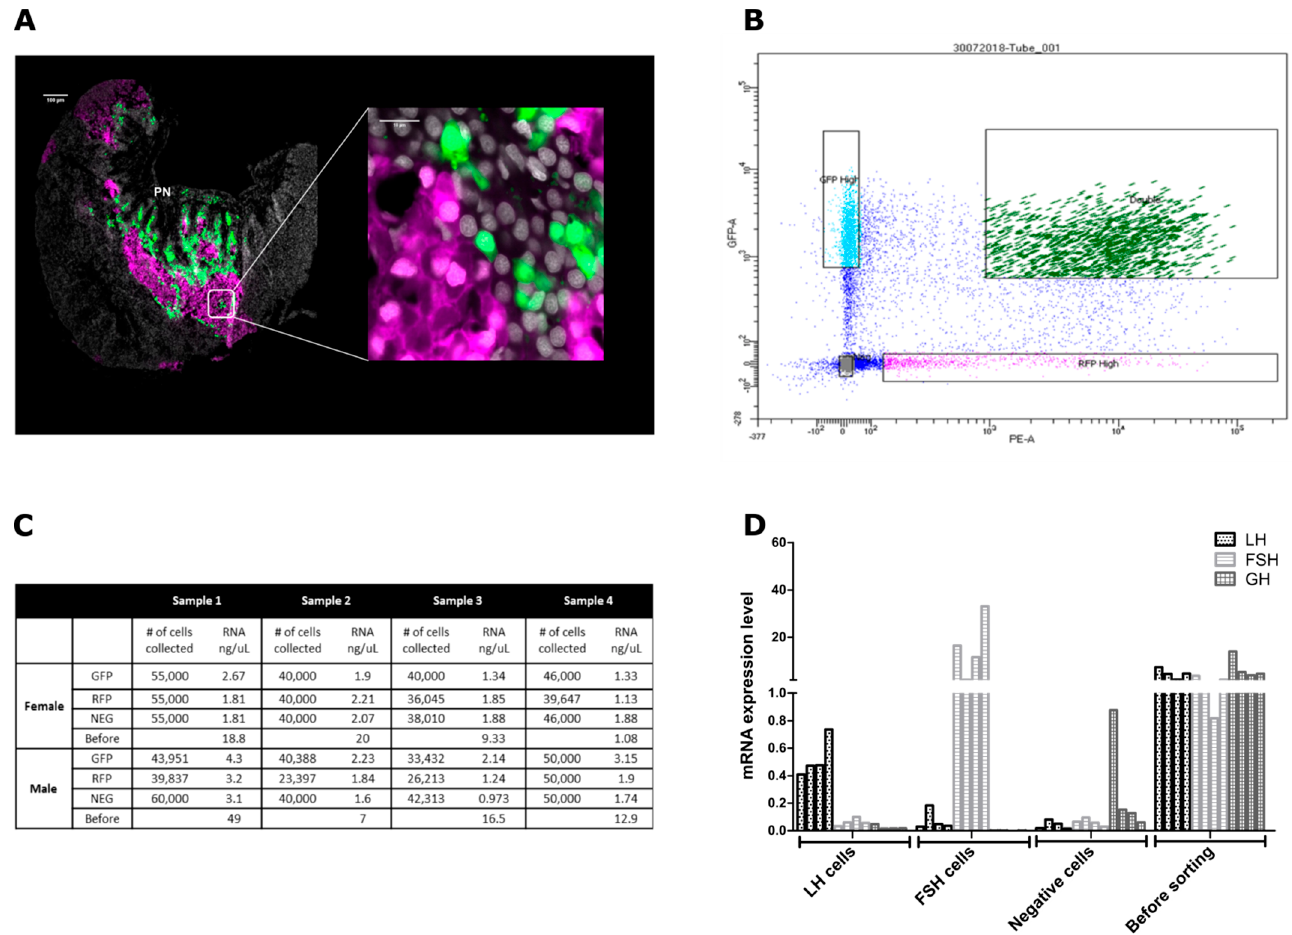
Figure 2. LH and FSH cells isolated from transgenic tilapia expressing double labeled pituitaries. ( A ) Confocal imaging of a double-labeled pituitary slice from mature transgenic Nile tilapia expressing RFP (magenta) under the regulation of LH promotor and GFP (green) under the regulation of FSH promoter. The right image contains a 60x magnification of the marked square in the left image revealing each hormone is expressed in a different cell. DAPI is used for visualizing the cell’s nucleus (gray). (PN) Pars nervosa. Scale bar: 100 μ M and 10 μ M. ( B ) Scatter plot showing separation between GFP and RFP marked cells of the FACS assayed cells that were collected from the double labeled pituitaries. In each FACS assay four fractions were collected: GFP high- FSH positive cells, RFP high- LH positive cells, double—RFP and GFP positive cells, and negative—all non-LH or FSH pituitary cells. For each FACS assay, between 16 and 21 pituitaries were